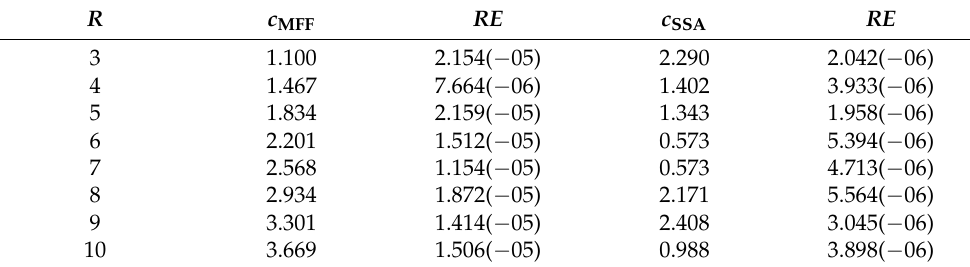
Table 4. The relative errors of the improved RBFCM with different R .